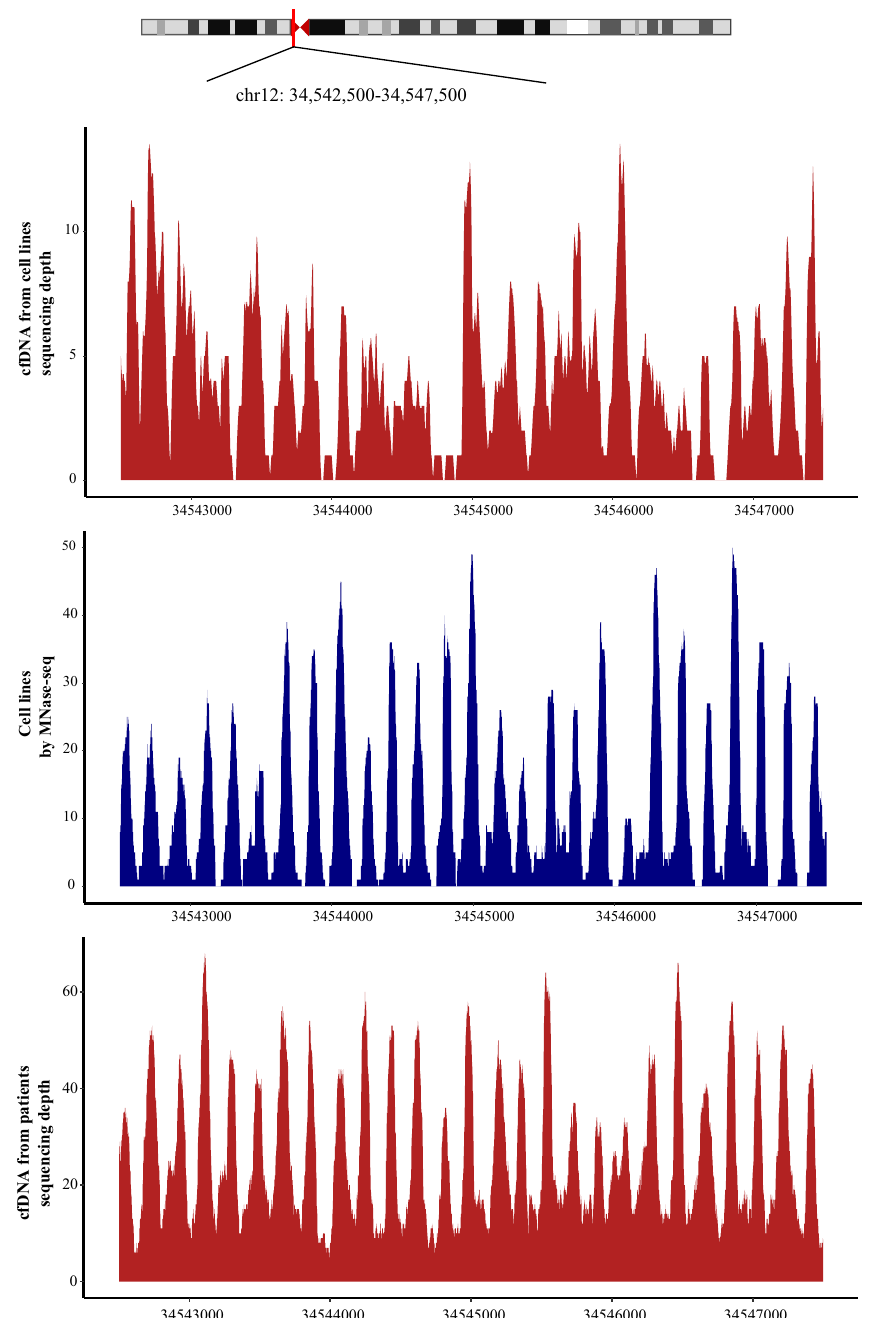
Fig. 2 Genome browser view in chromosome 12 with enlargement of 12p11.1. CfDNA-seq data from the MDA-MB-231 and T-47D cell lines (up), MNase-seq data from the MDA-MB-231 and T-47D cell lines (mid), and circulating cell-free DNA from breast cancer patients (down). The region contains an extreme example of sequence-directed nucleosome positioning. Read depth coverage for cfDNA-seq data from cell lines ( n = 2; merged data) and patients ( n = 50; merged data) is shown in red, and the MNase midpoint density map from cell lines cell lines ( n = 2; merged data) is shown in Different TSSs in pretreatment cfDNA between patients with breast cancer and healthy individuals We compared sequence coverage depth around cfDNA TSSs between patients with breast cancer and healthy donors. Technical reproducibility was evaluated using six samples, and the distance of each three technical replicates of the same sample was closer than those from different samples based on PCA analysis. (Supplementary Fig. 2). Among a total of 32444 tested